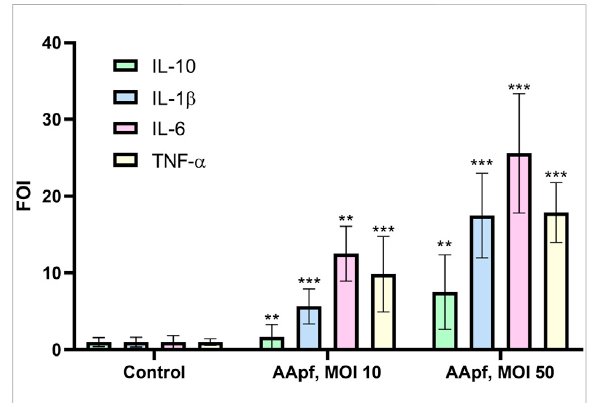
Gene expression analysis by qRT-PCR in THP-1 human macrophages unstimulated (Control) and after 4 h of stimulation with the AminoAlta ™ probiotic formulation (AApf) at a multiplicity of infection (MOI) of 10 and 50. Expression levels of IL-10, IL- 1 β ,IL-6,andTNF- α areshownasthefoldchangeininduction(FOI) relative to expression by the control (unstimulated macrophages), which was set at a value of 1. Data are means of results from three (control and MOI 10) or two (MOI 50) independent experiments ± standard deviations. Asterisks indicate statistically signi fi cant differences (according to a two-tailed unpaired Student ’ s t-test) from results for unstimulated THP-1 cells. ***, p < 0.001; **, p <